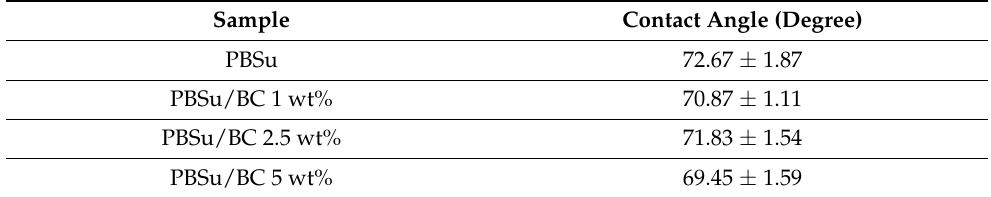
Table 6. Contact angle measurements of prepared